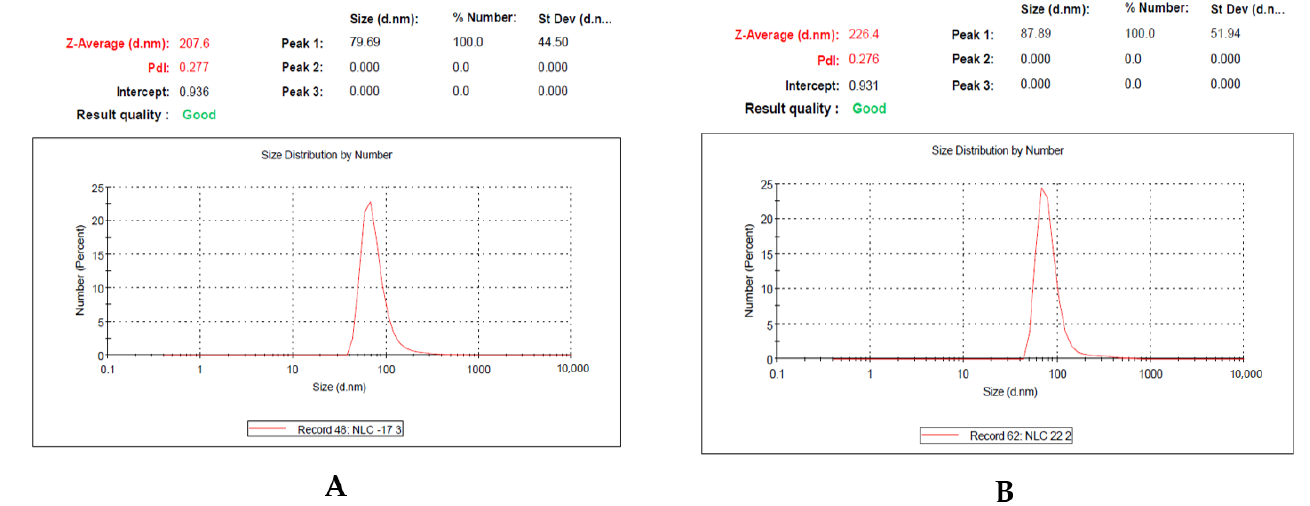
Figure 2. Data of particle-size distribution and zeta potential of the prepared nanoemulsion; ( A ): Nanoemulsion without drug; ( B ): Methotrexate-loaded nanoemulsion.